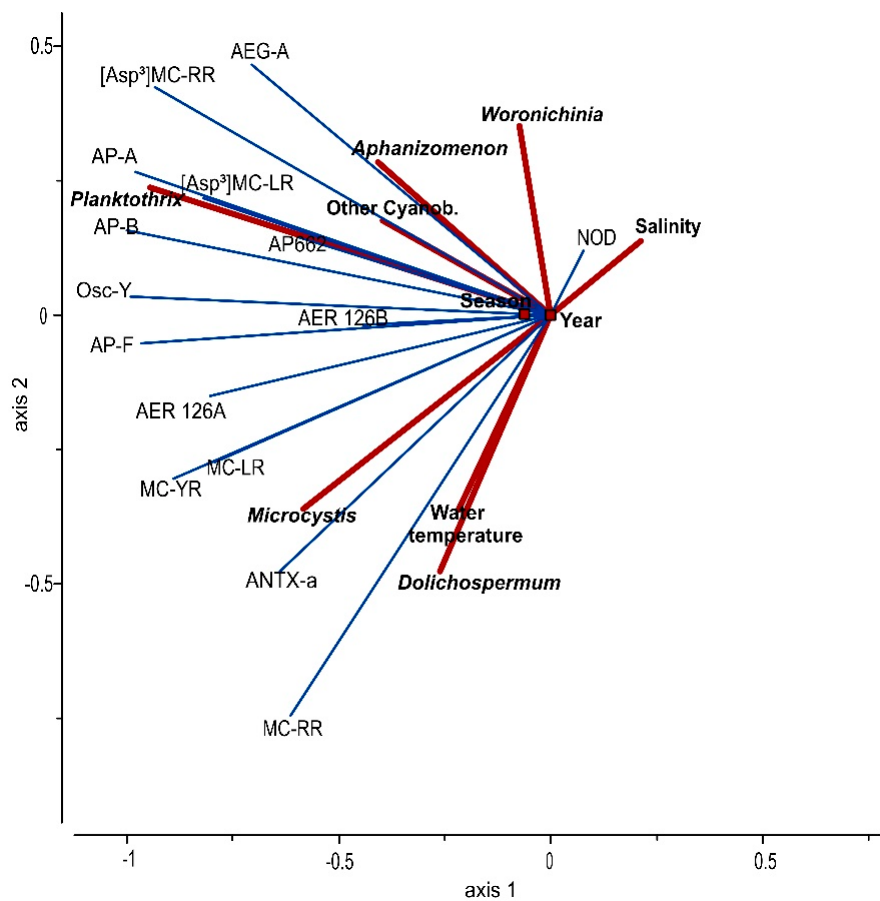
Figure 8. The distribution of the NRPs (response variables, thin blue lines) in relation with the main potentially toxic cyanobacteria and abiotic factors (explanatory variables, solid red lines).